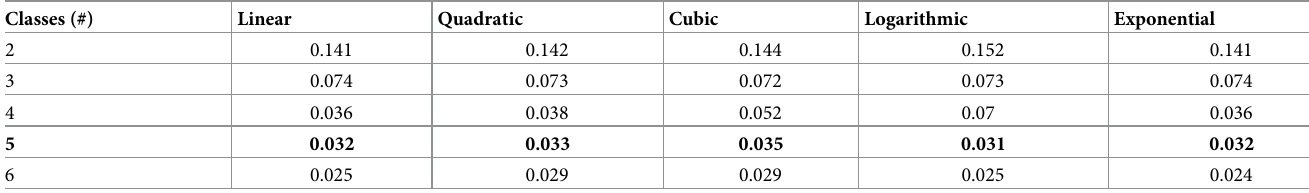
Table 1. Lowest proportion of subjects in a latent class for complete